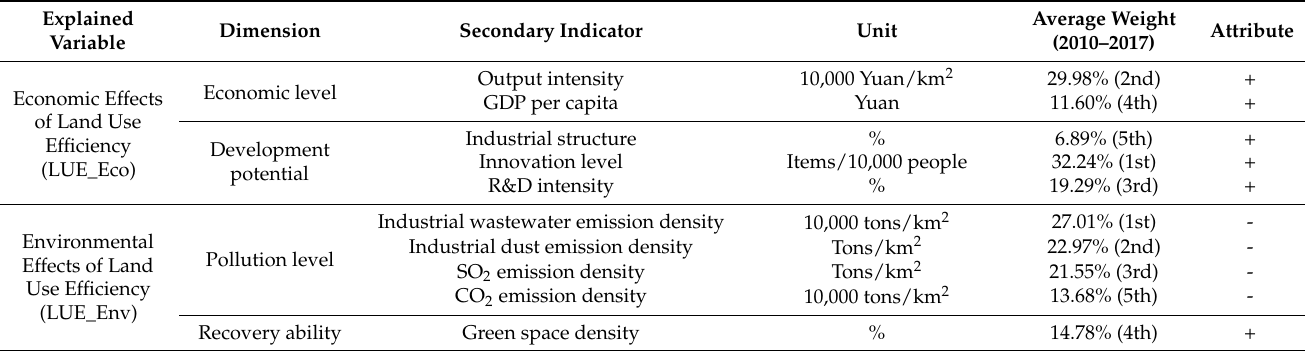
Table 1. Land use efficiency evolution system in economic and environmental effects. Explained Variable